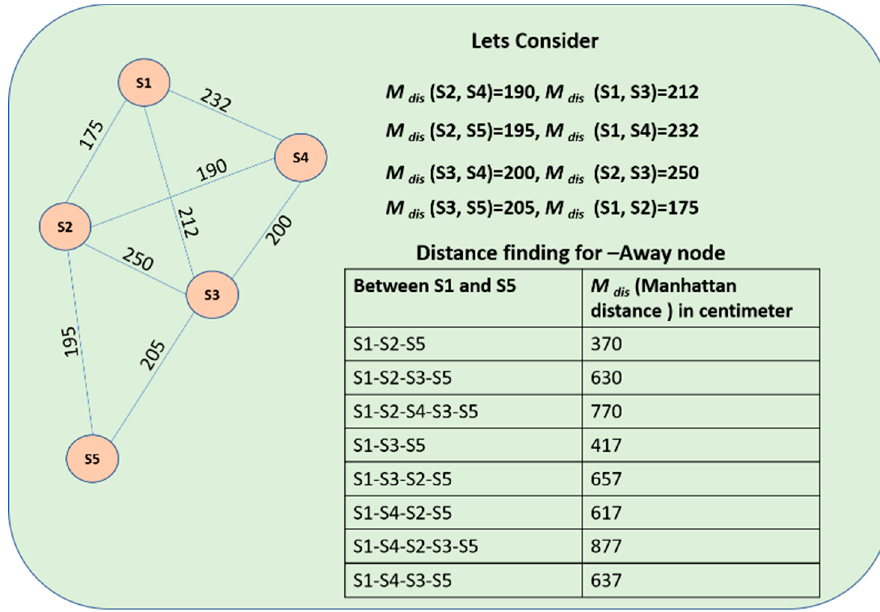
Figure 8 . Far-away node distance calculation using Manhattan method. Figure 8. Far-away node distance calculation using Manhattan